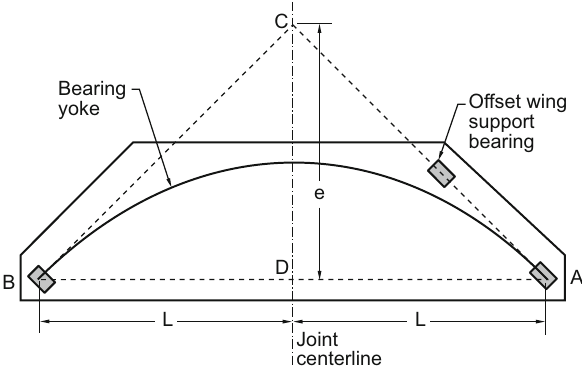
Fig. 7 Trapezoidal wing geometry and wing bearing